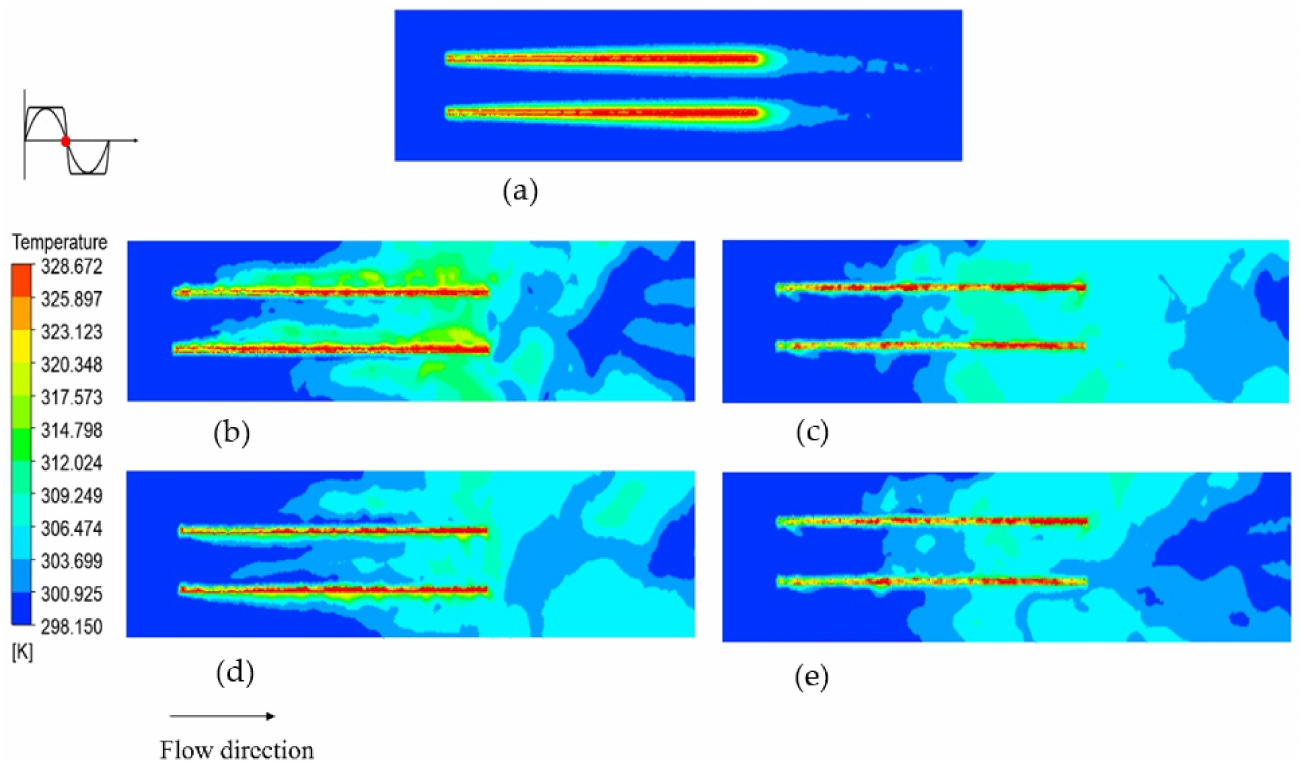
Figure 9. Temperature profiles on a plane passing across the tip of the heat sink at Re = 1000: ( a ) static heat sink; ( b ) sinusoidal wave shape, f = 100 Hz, Amp = 0.003 m; ( c ) square wave shape, f = 100 Hz, Amp = 0.003 m; ( d ) sinusoidal wave shape, f = 100 Hz, and Amp = 0.005 m; ( e ) square wave shape, f = 100 Hz, Amp = 0.005